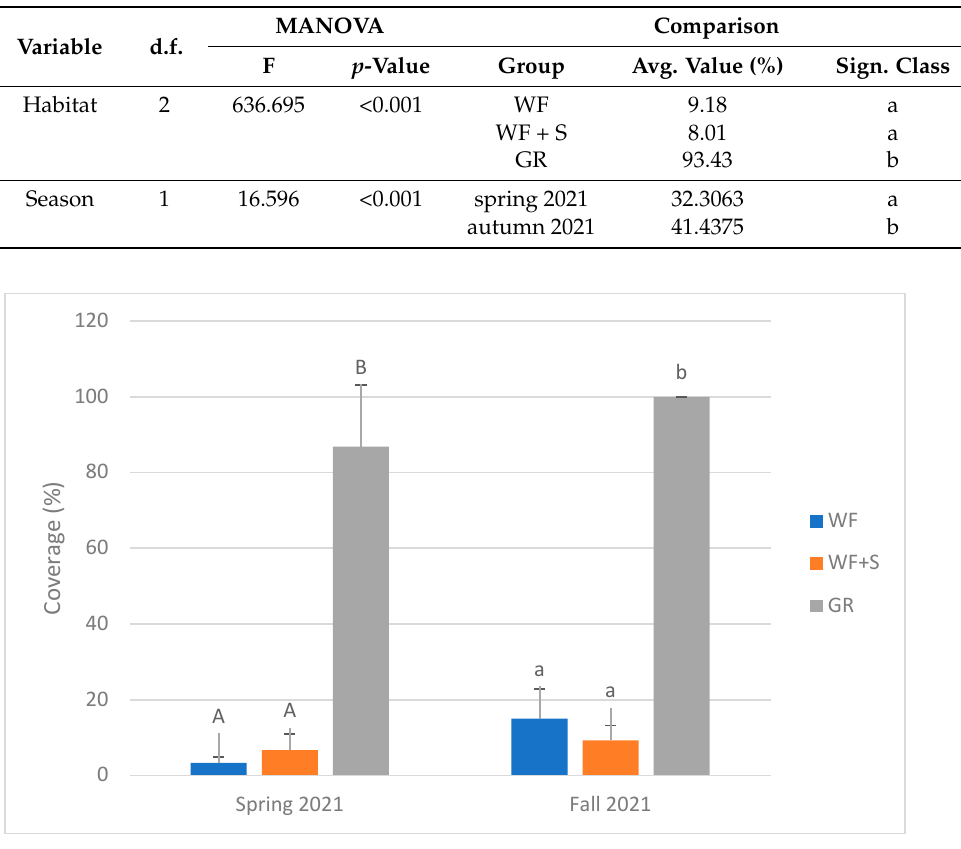
Figure 11. Effect of habitat and season on plant vegetation (total cover). Same letters above bars mean no statistical difference. (WF: weed control fabric; WF + S: weed control fabric and straw; GR: grass vegetation; ˝Osag á rd,